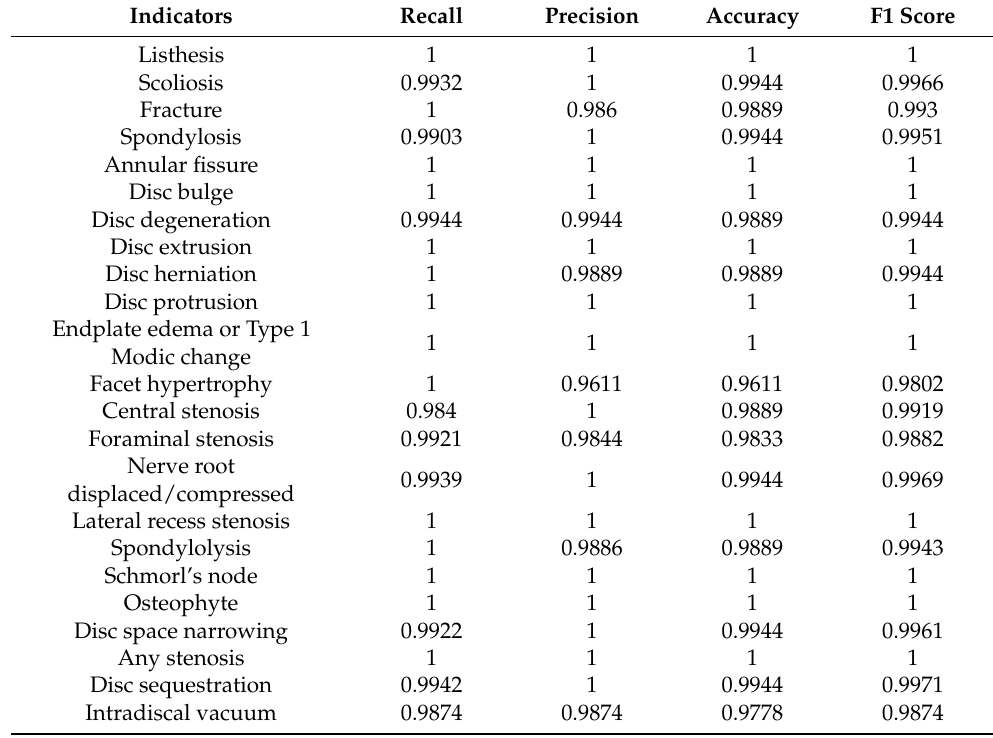
Table 3. Performance of the natural language processing pipeline in the test dataset (N =